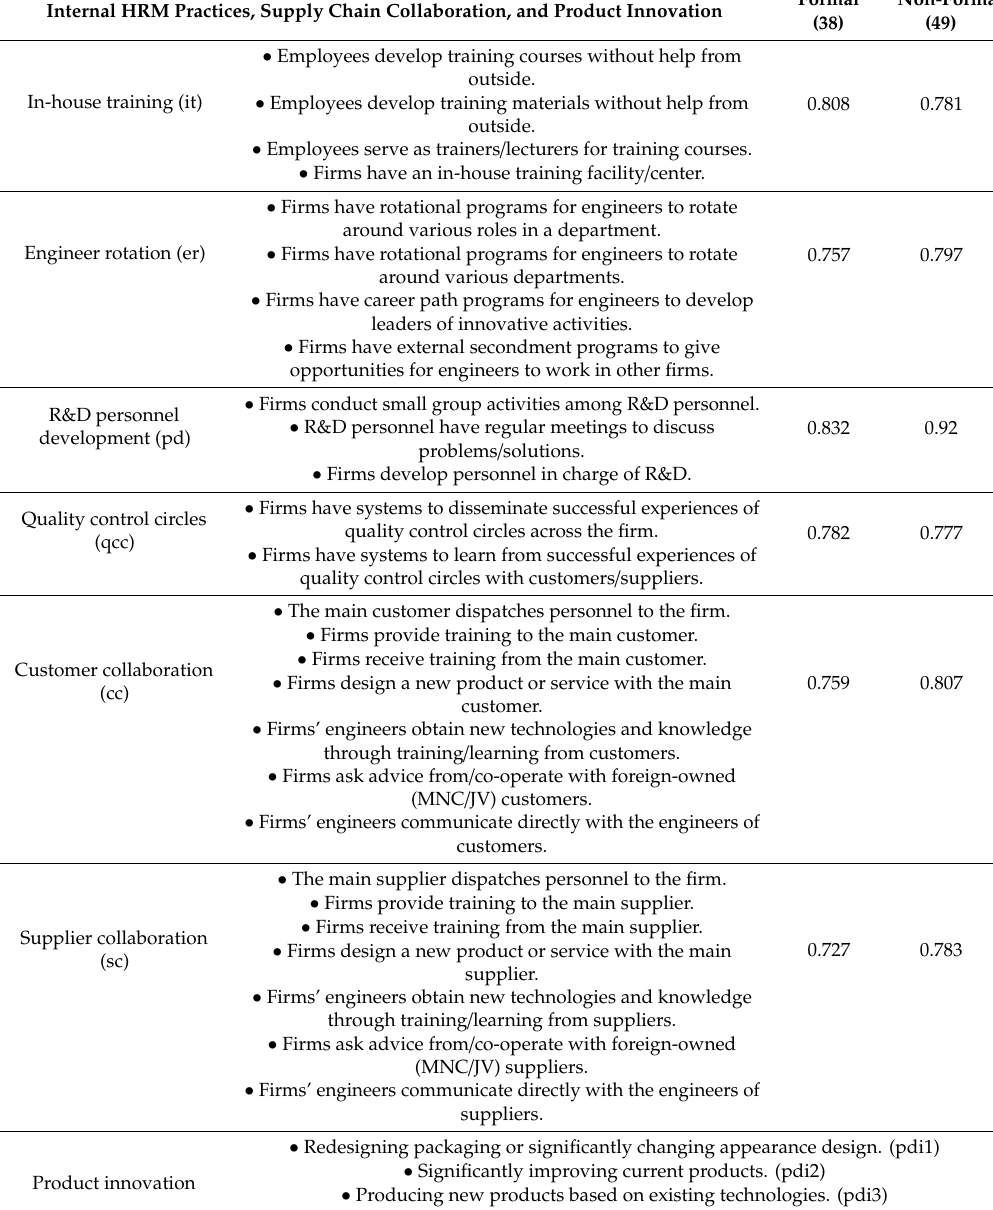
Table 1. Cronbach’s alpha of causal conditions and